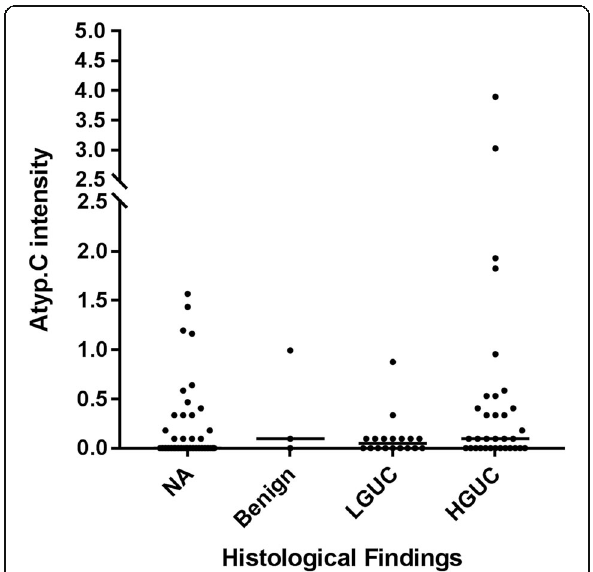
Fig. 3 A dot plot showing Atyp.C intensity in benign, LGUC and HGUC groups identified by histology. NA, not available (lost in the follow-up); LGUC, low-grade urothelial carcinoma; HGUC, high-grade urothelial carcinoma. The original Atyp.C data was transformed as “ ln (Atyp.C intensity+1) ” in the Y